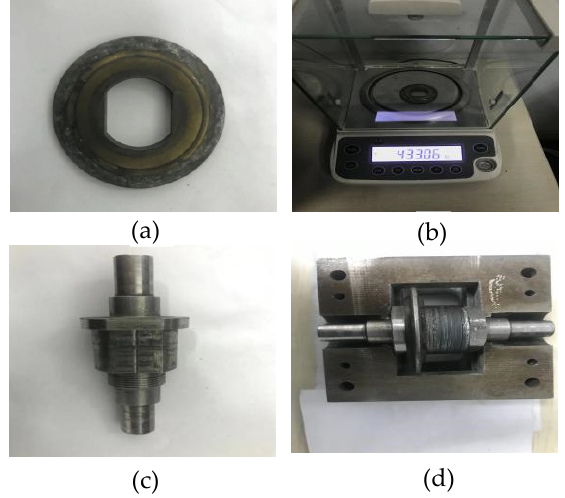
Figure 4. Installation of the reduced-scale TBM cutter and the fixture: ( a ) Reduced-scale TBM cutter; ( b ) Cutter weighing; ( c ) Cutter shaft; ( d ) Cutter